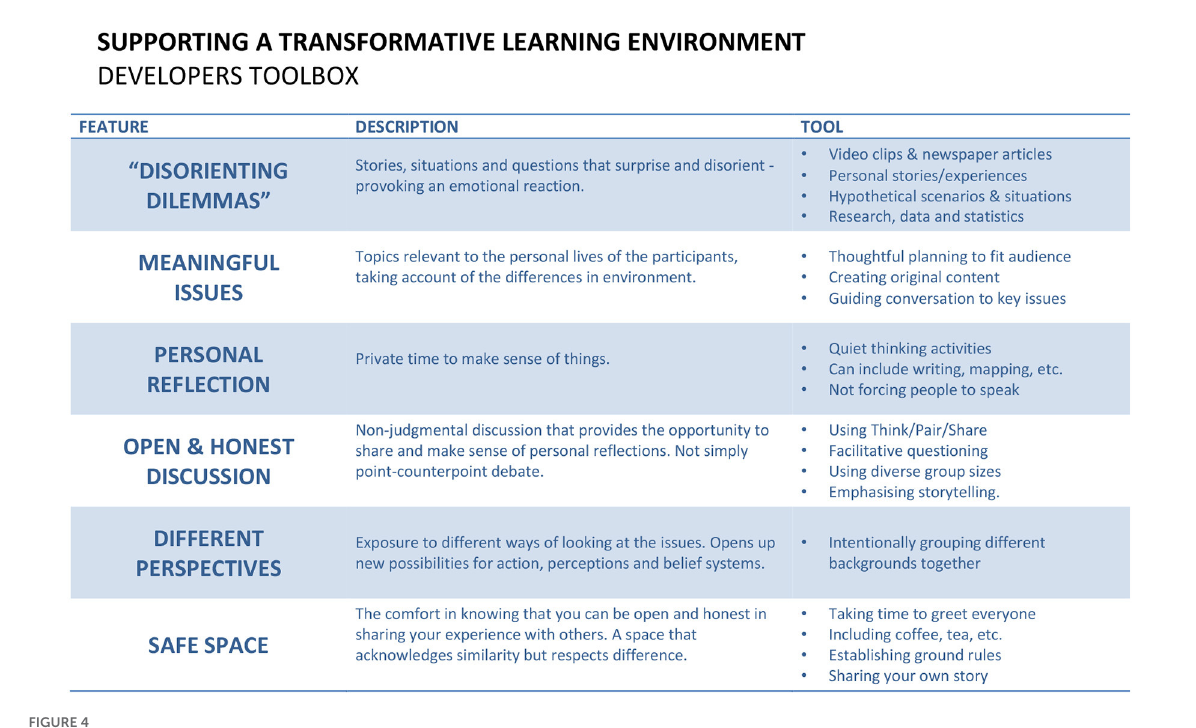
FIGURE4 Transformative learning developer